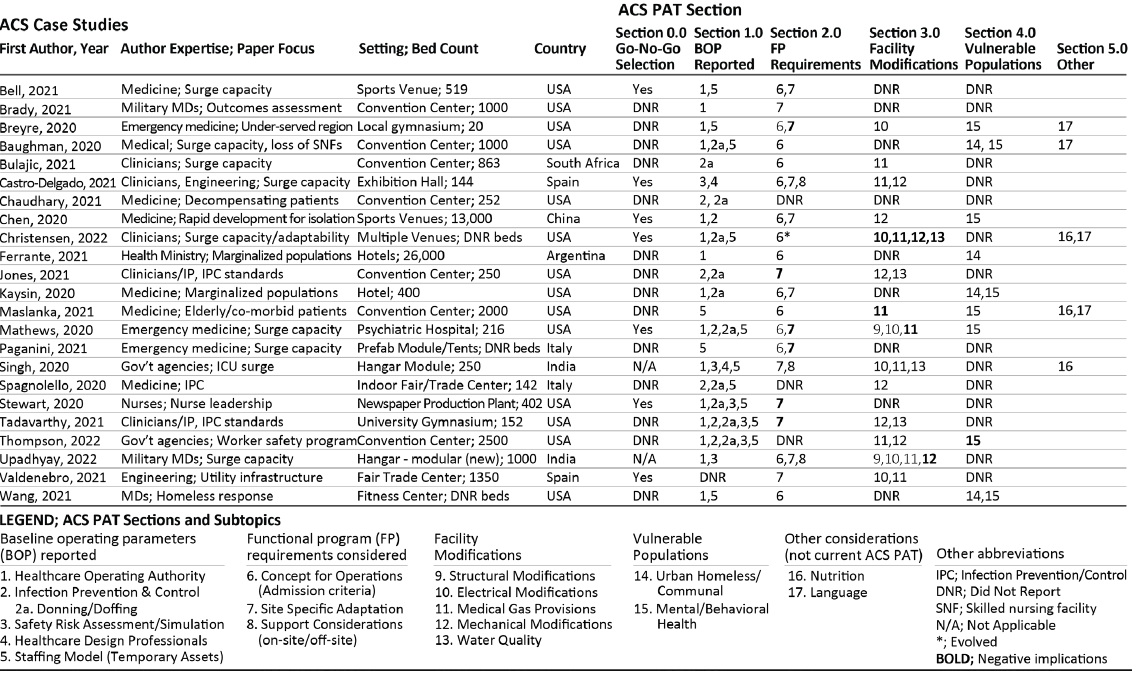
Figure 4. ACS Case Study Summary Comparison with COVID-19 ACS PAT Criteria.